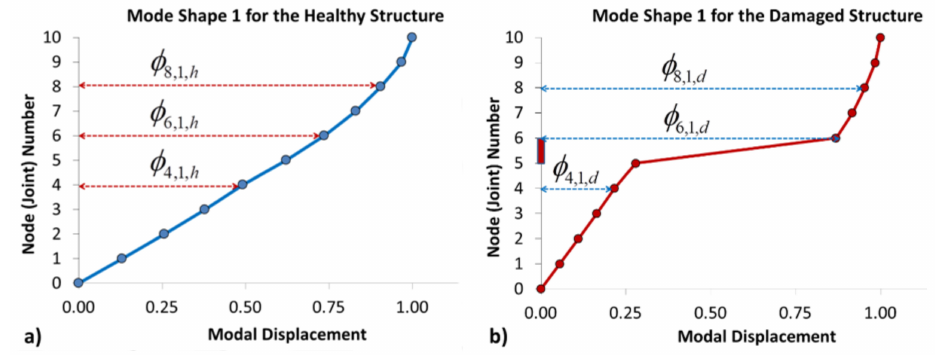
Figure 6. Modal shapes extracted from ( a ) the healthy and ( b ) flawed